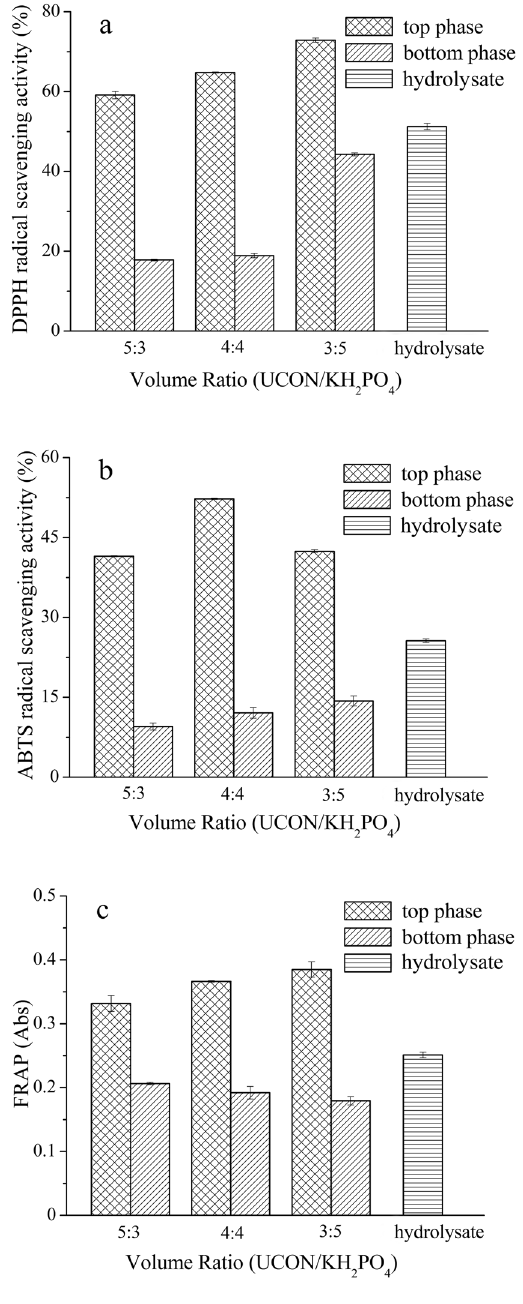
Figure 2. Effect of the ratio of the volumes of UCON and KH 2 PO 4 on the separation of antioxidant peptides. ( a ) DPPH radical scavenging activity; ( b ) ABTS radical scavenging activity; ( c ) ferric reducing antioxidant power